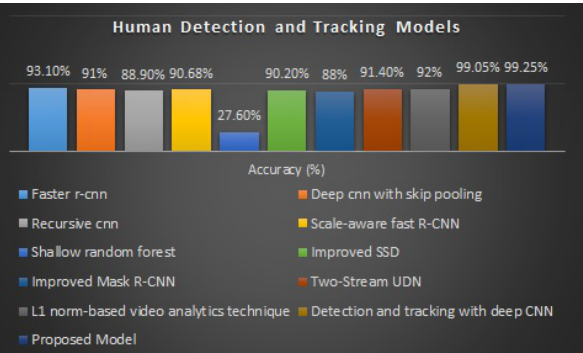
Figure 20. Bar graph of human detection and tracking